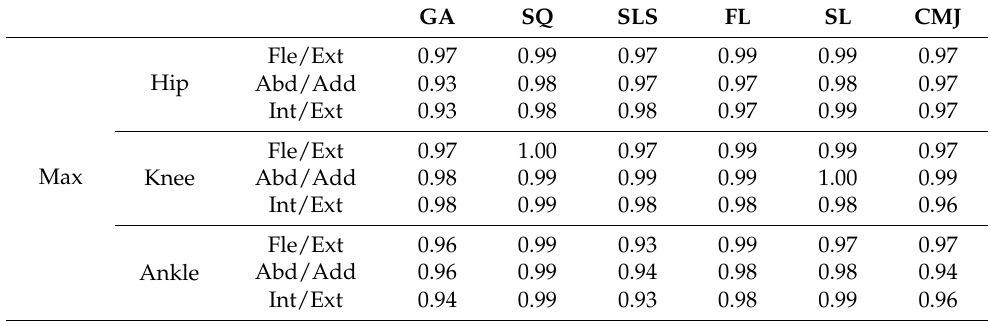
Table 3. The intraclass correlation coefficient (ICC) of IMU system collected in all